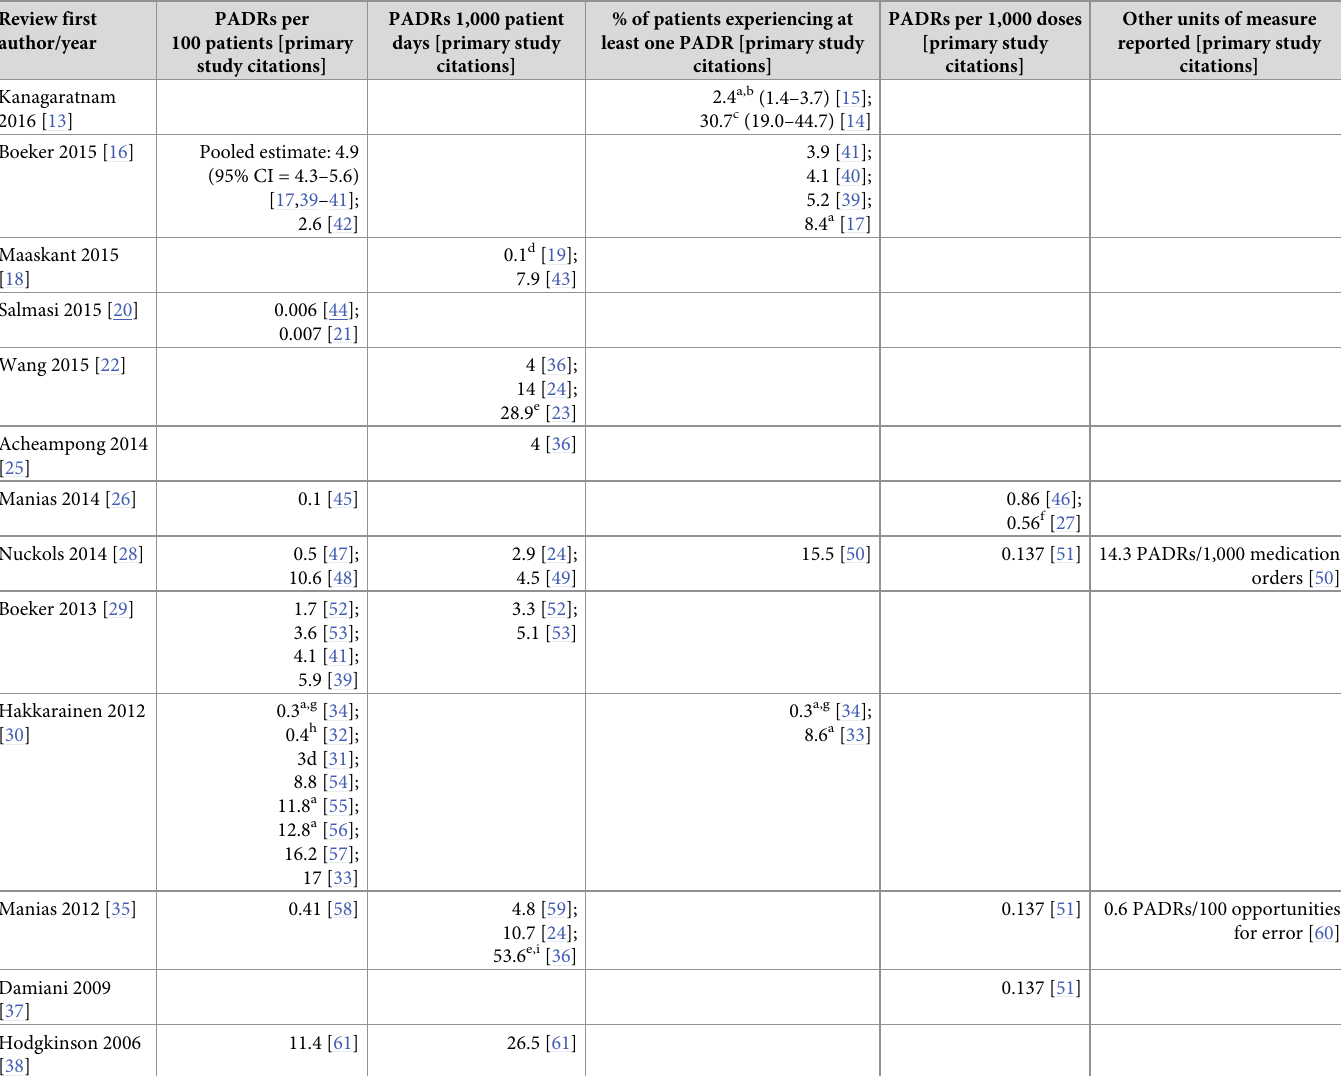
Table 4. PADR incidence reported in the 13 included systematic